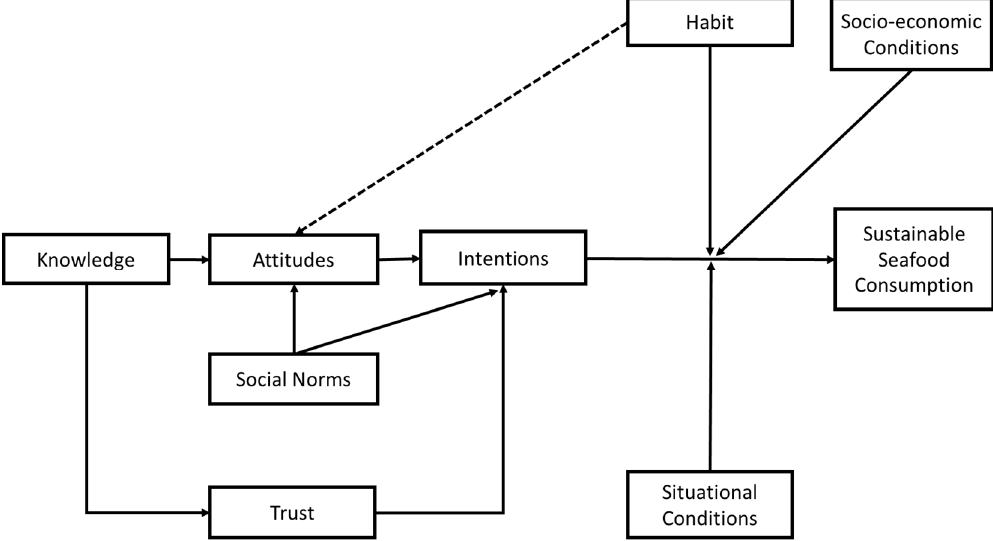
Figure 1. A comprehensive model for sustainable seafood consumption.